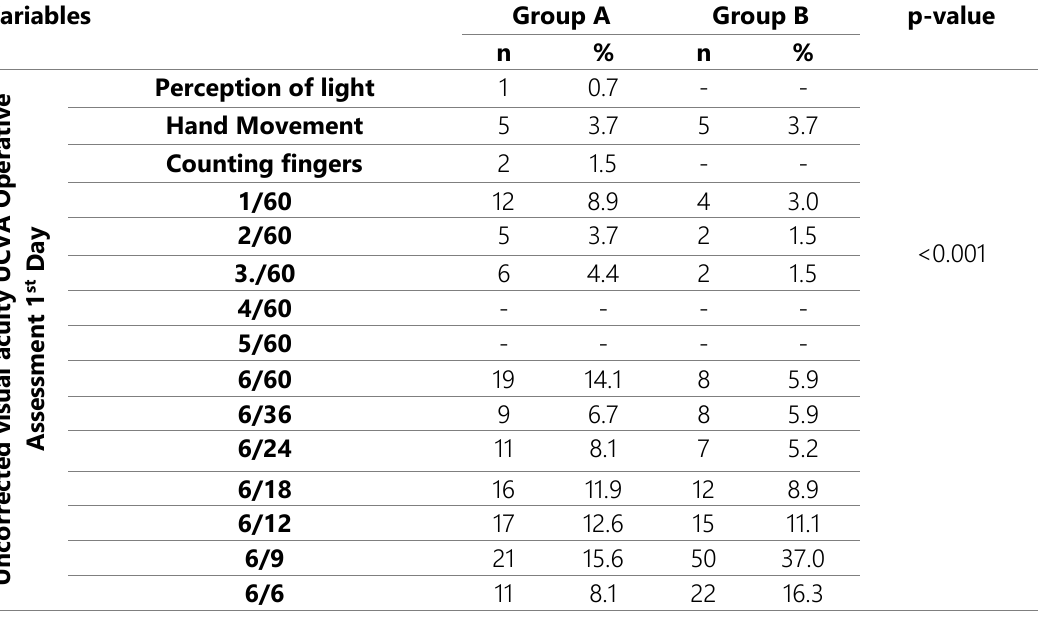
*p-value <0.05 is considered significant.